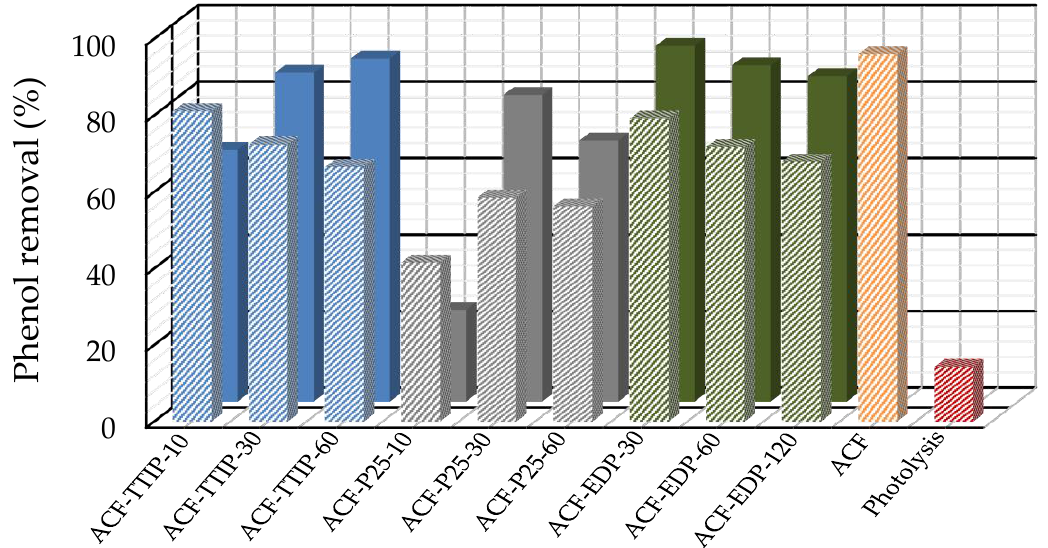
Figure 4. Percentage removal of phenol by the prepared ACF / TiO 2 composite adsorbents due to adsorption (shaded blocks) and combination of adsorption with photocatalysis (solid blocks).